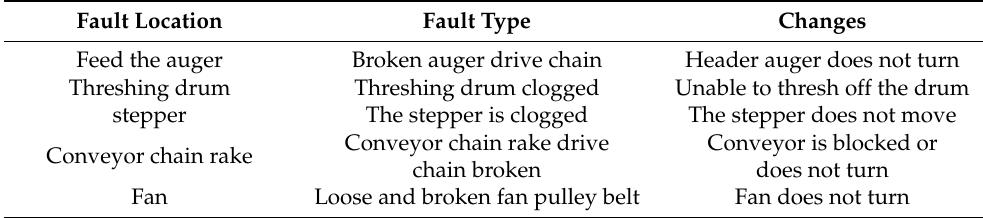
Table 3. Changes of main parameters of five types of combine